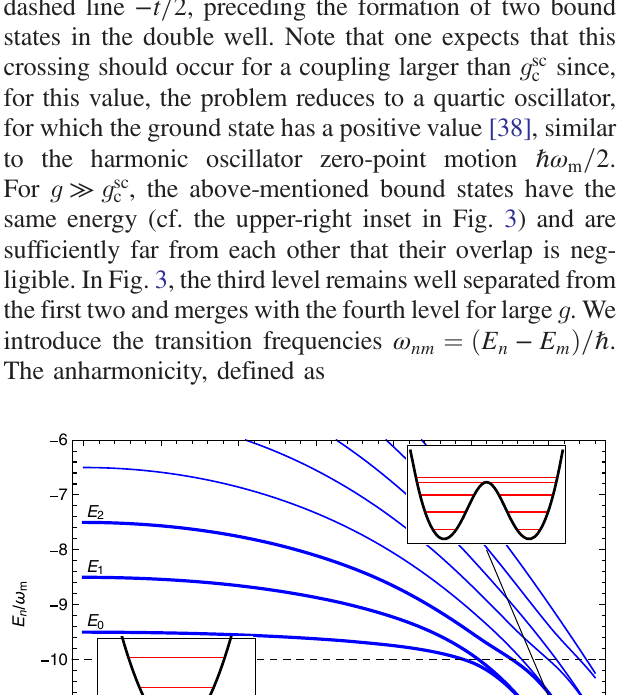
FIG. 3. Lowest-lying energy eigenvalues E (1) for ϵ ¼ 0 and t ¼ 20 ℏ ω Oppenheimer potential given by Eq. (2) and the energy levels are shown in the insets for g ¼ 0 and g ¼ 3 . 2 ω line indicates the lowest noninteracting electronic level − t= 2 . The semiclassical critical value for the bistability is g sc p 5 ≈ 2 . 23 . The value of g ¼ g monicity is 5% is also